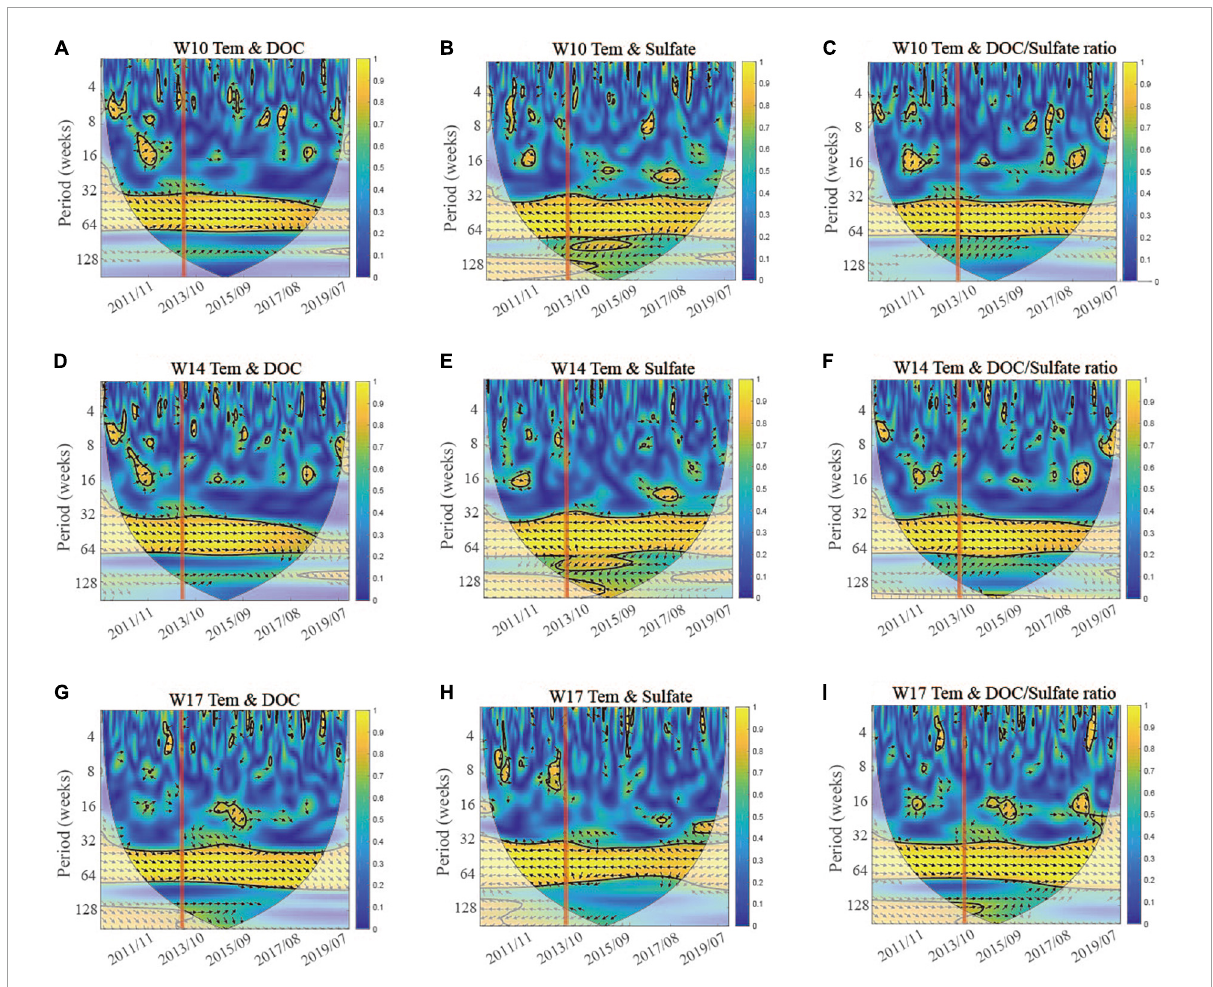
FIGURE6 The WTC analysis between temperature (Tem) and dissolved organic carbon (DOC), sulfate, DOC/Sulfate ratio at 3 Wüstebach catchment stations (W10, W14, W17). The X -axis indicates the time and the y -axis displays the periods (in weeks). The cone of influence (COI) is shown as a cone-shaped area with thick black line (95% confidence level based on Monte Carlo test). The different colors indicate the strength of the correlation ( R 2 ) from 0 to 1. The black arrows indicate the orientation of the correlation with R 2 > 0.5 and the phase shifts between two variables (right directed: in-phase, positive, left directed: anti-phase, negative). The vertical red line indicates that the moment deforestation occurred in late summer